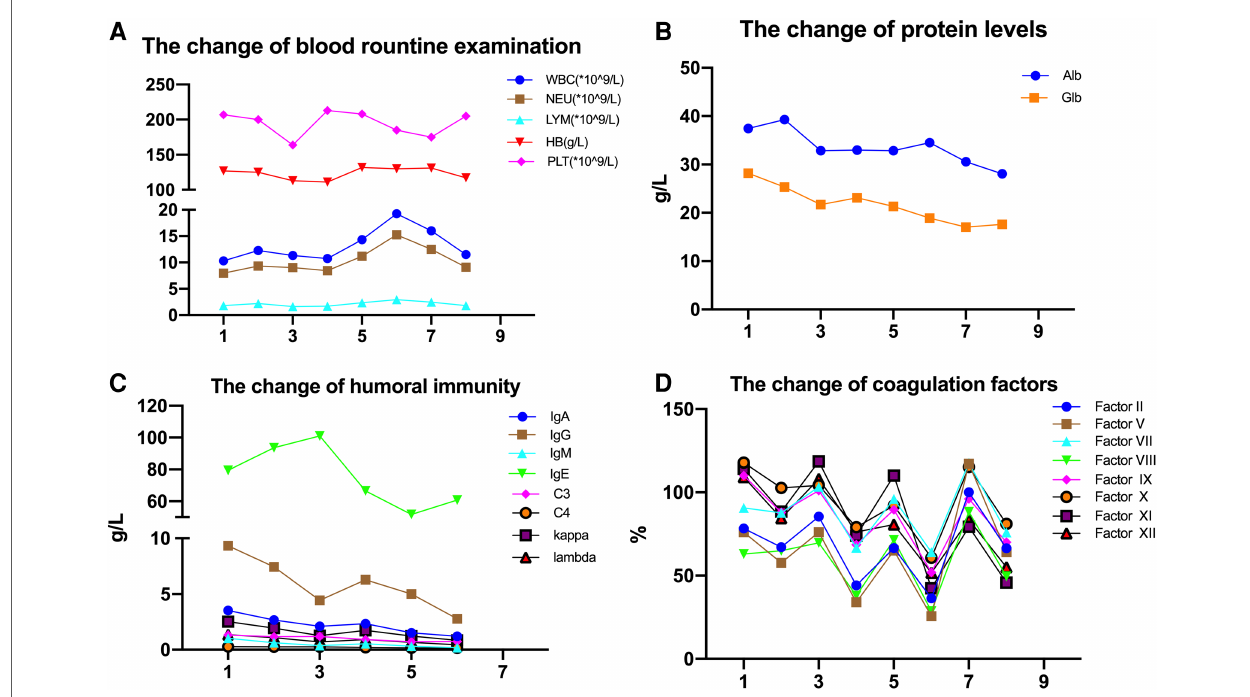
FIGURE 4 ( A – D ) the fl uctuations of blood routine and protein level over the whole treatment period (case 1). Odd numbers represent pre-DFPP. Reference range: WBC, 3.5 – 9.5*10 9 /L; NEU, 1.8 – 6.3*10 9 /L; LYM, 1.1 – 3.2*10 9 /L; Hb, 115 – 150 g/L; Alb, 40 – 55 g/L; Glb, 20 – 40 g/L; IgA, 0.7 – 4.0 g/L; IgG, 7 – 16 g/L; IgM, 0.4 – 2.3 g/L; C3, 0.9 – 1.8 g/L; C4, 0.1 – 0.4 g/L; kappa, 1.7 – 3.7 g/L; lambda, 0.9 – 2.1 g/L; factor II, 70 – 100 (%); factor V, 70 – 120 (%); factor VII, 70 – 120 (%); factor VIII, 70 – 150 (%); factor IX, 70 – 120 (%); factor X, 70 – 120 (%); factor XI, 70 – 120 (%); factor XII 70 – 150